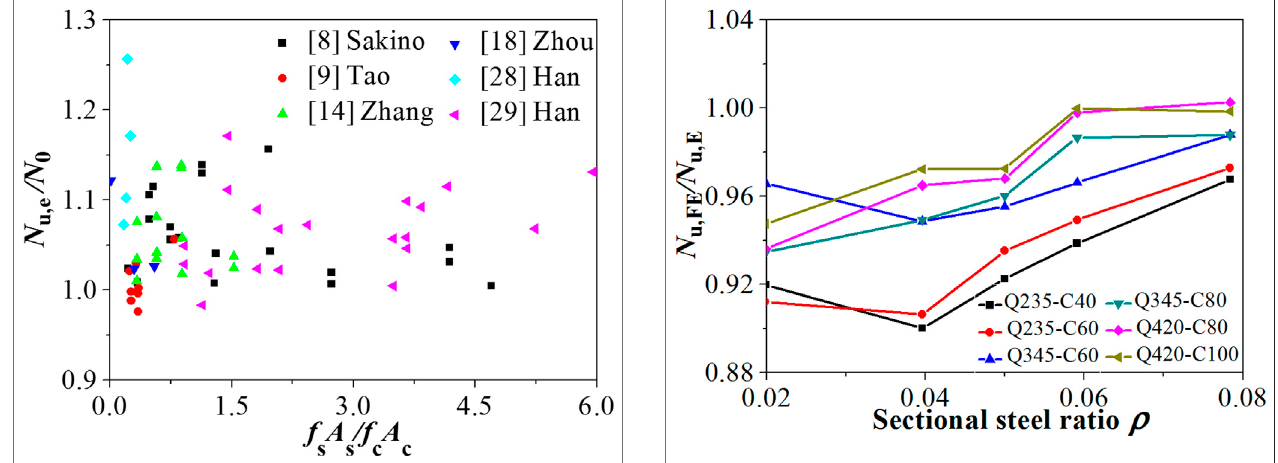
FIGURE 11 | Relationship between force ratio and bearing capacity improvement coef fi cient.